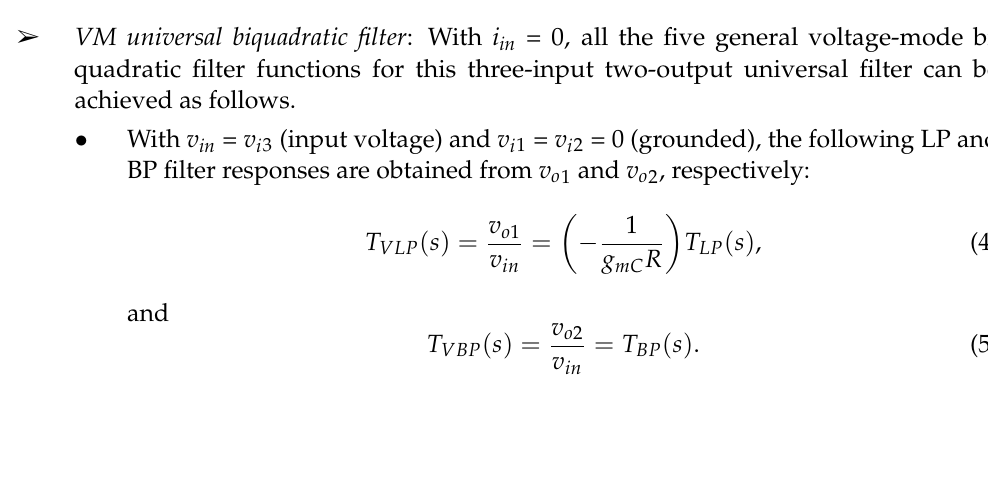
Figure 3. Proposed mixed-mode universal biquadratic filter.